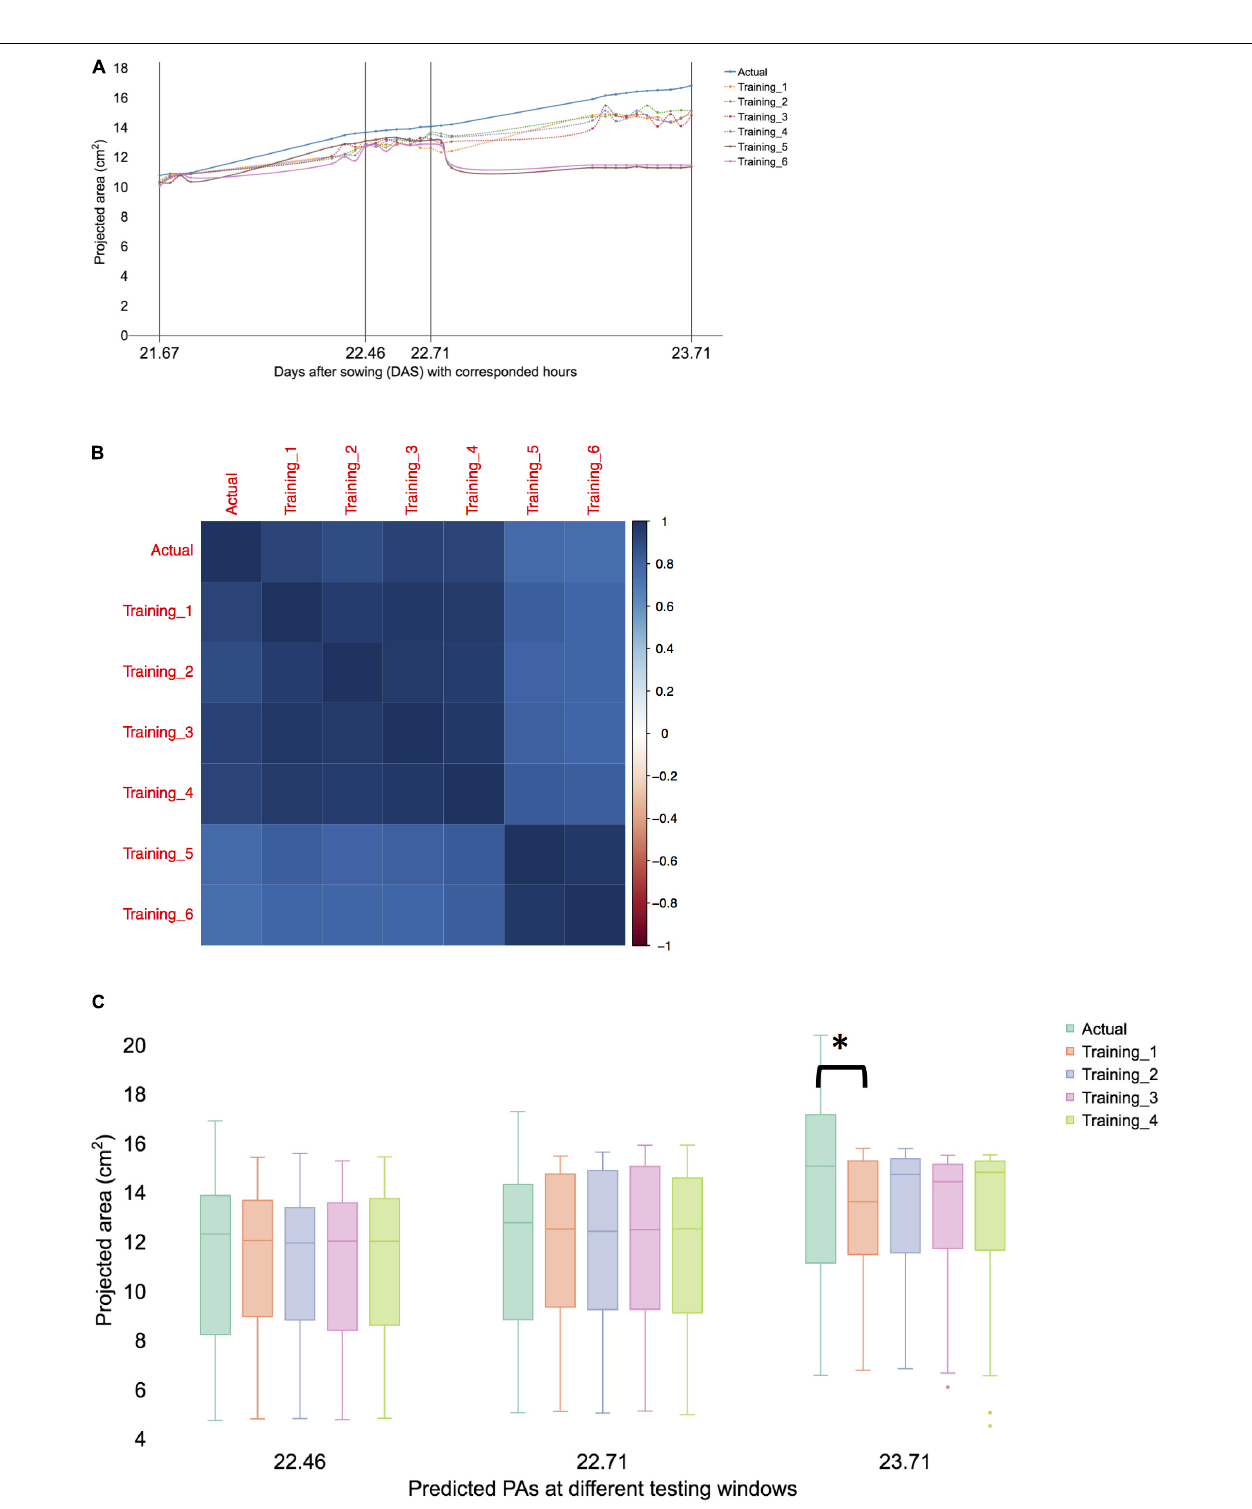
FIGURE 4 | Predicted total leaf area and error range from 21 to 23 DAS in selected and total samples. Time points format as format images were taken at DAS (DAS.hours). MAE was calculated using multiple time windows with various forecast time points. (A) Predicted values with multiple time windows of the dataset ( Figure 3 ) at 21–23 DAS (validation time points) of sample ID 98. (B) Correlation plot of all samples at 23.71. Clustering and grouping with R library for arranged samples. (C) Predicted PAs with training sets 1–4 at the selected testing window are given as 22.26, 22.71, and 23.71. The result is shown in a boxplot of actual and predicted PAs from each testing model. We compared with post hoc statistical test (Tukey’s HSD) and the significant result is showed with an asterisk.